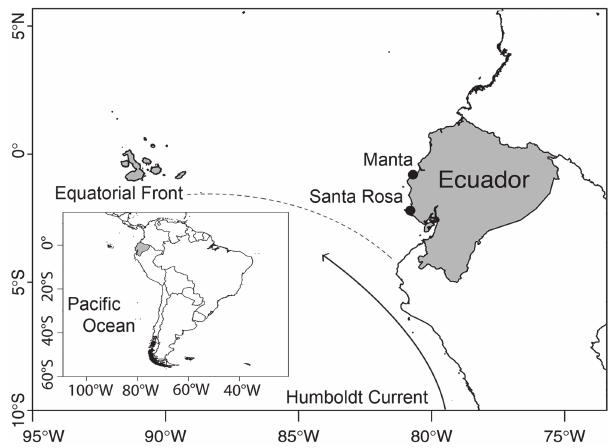
Fig. 1. Map showing the study area. Filled circles represent the sampling localities. Stomach content analysis. The stomach contents were identified to the lowest taxonomic level, and prey species were counted and weighed to the nearest 0.01 g. Whole fish and cephalopods were identified following Fischer et